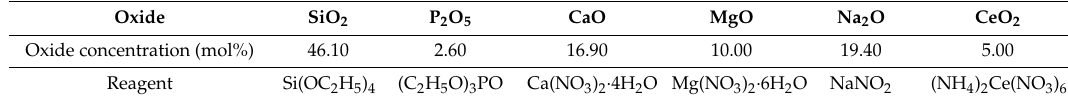
Table 1. Oxide composition and employed reagents.